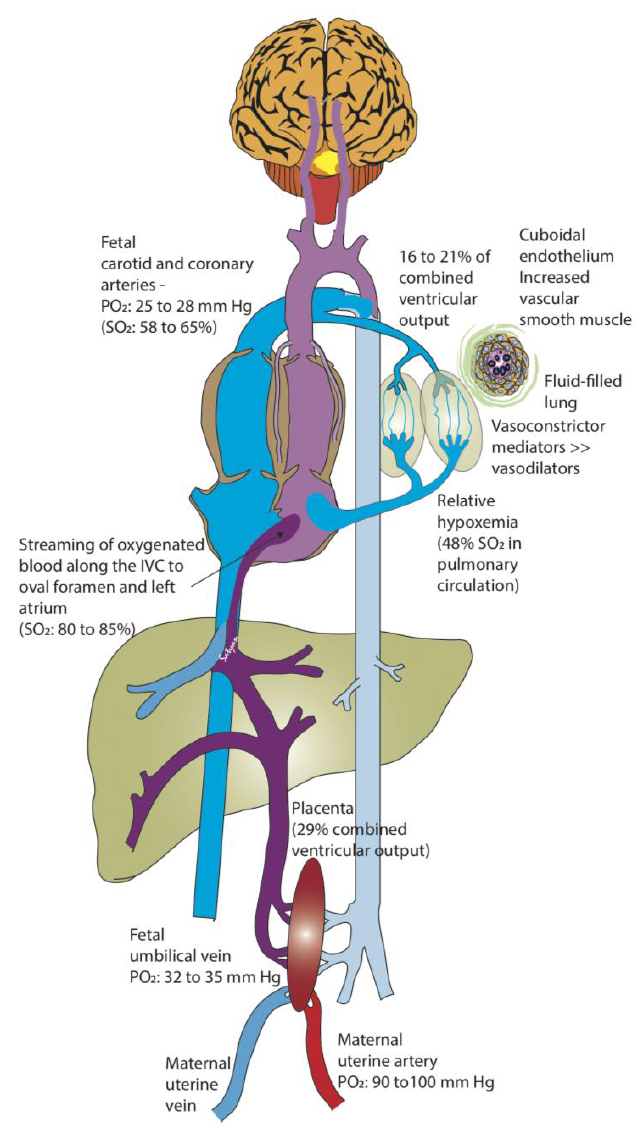
Figure 1. Fetal circulation. The placenta serves as a major buffer in reducing oxygen exposure to the fetus. The partial oxygen tension (PO 2 ) in the maternal uterine artery is 90–100 mm Hg compared to 32–35 mm Hg in the fetal umbilical vein (UV). The relatively higher oxygenated UV blood does not completely mix with the blood returning from the fetal body in the inferior vena cava (IVC), and is preferentially streamed towards the left atrium (through the foramen ovale). As the lungs do not participate in gas exchange in utero, the fetal pulmonary vascular resistance is very high, and the pulmonary circulation only receives 16–21% of the combined ventricular cardiac output (by phase-contrast MRI and Doppler studies) in the near-term human fetus. As a result, there is only a small amount of desaturated blood from the pulmonary veins draining into the left atrium, maintaining a relatively high PO 2 in the left heart. Therefore, the blood pumped into the aorta supplying the brain and coronaries contains the highest fetal PO 2 (25–28 mm Hg: saturation 58% in human fetus and 65% in fetal lambs). Desaturated blood returning from the brain and the body into the right heart is pumped through the pulmonary artery and is mostly diverted through the ductus arteriosus to supply the rest of the body. Approximately 29–30% of the combined ventricular cardiac output circulates to the placenta. SO 2 : oxyhemoglobin saturation (Copyright Satyan Lakshminrusimha).